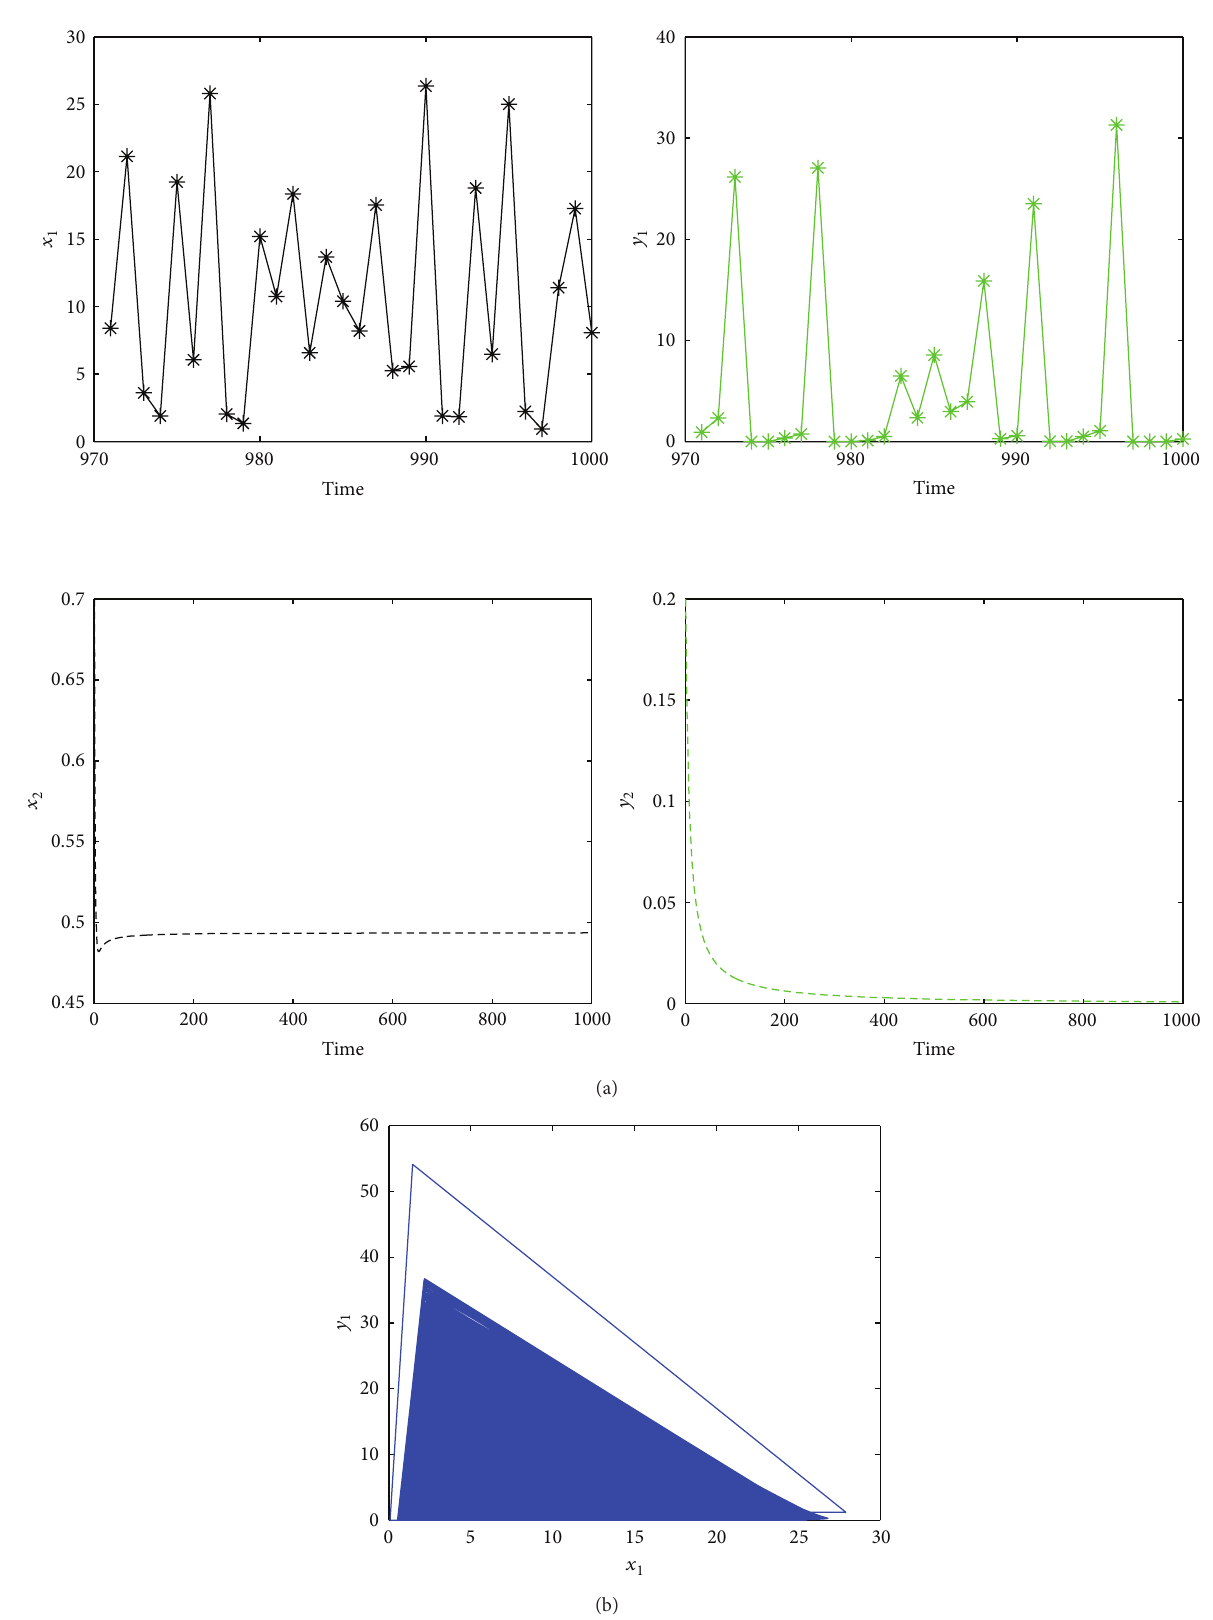
Figure 6: The dynamics of model (45). (a) is the dynamics of (45). It is observed that the predator in patch 2 will become extinct due to the dispersal corridors, and (45), as a whole, is not permanent. (b) is the dynamics of the subsystem of patch 1 illustrated in the phase diagram , 𝑦 ) . The periodic solution in Figure 5(b) vanishes due to (𝑥 1 1